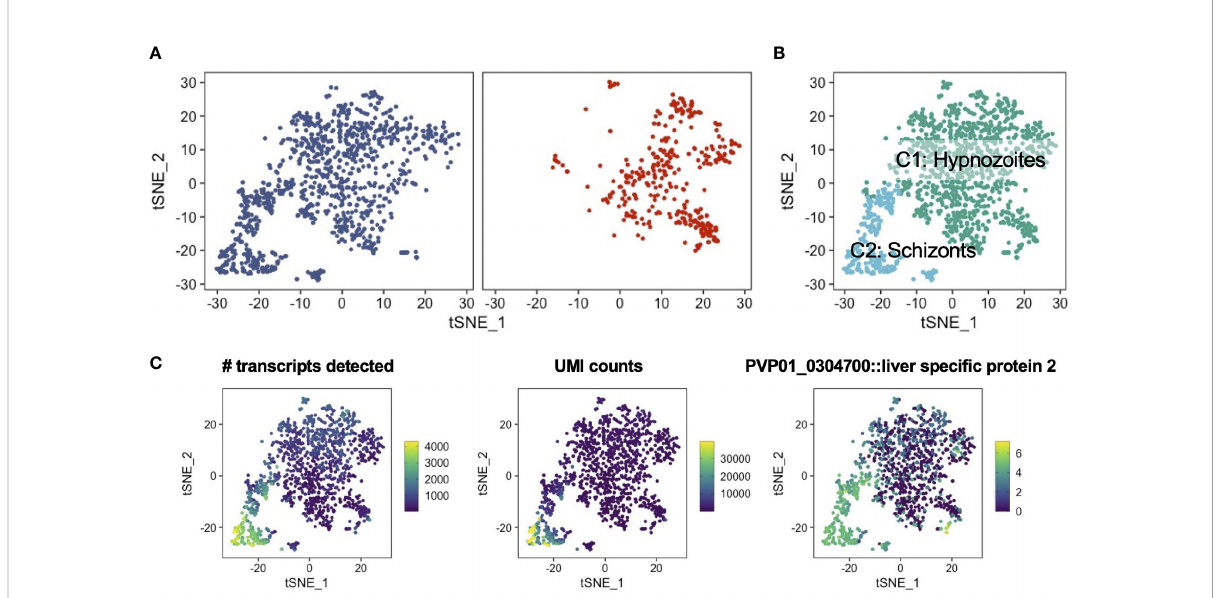
FIGURE 2 Low dimensional representation of P. vivax schizont and hypnozoite transcriptomes. (A) t-SNE plots of integrated P. vivax liver stage scRNA-seq data faceted by parasites isolated on day 5 (left) and day 9 (right) post-infection. (B) t-SNE plot of P. vivax liver stage data colored by parasites encoding for putative hypnozoites (C1) and schizonts (C2). (C) t-SNE plots of P. vivax liver stage scRNA-seq data colored by number of transcripts detected (left), UMI counts (middle), and the expression of the schizont marker, LISP2 (PVP01_0304700) (right). Scales: absolute count (left, middle), normalized expression